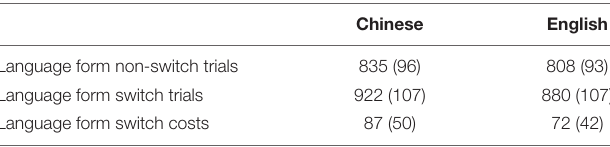
TABLE 3 | Mean RTs in ms (SD) in language form non-switch and switch trials and switch costs presented separately for Chinese and